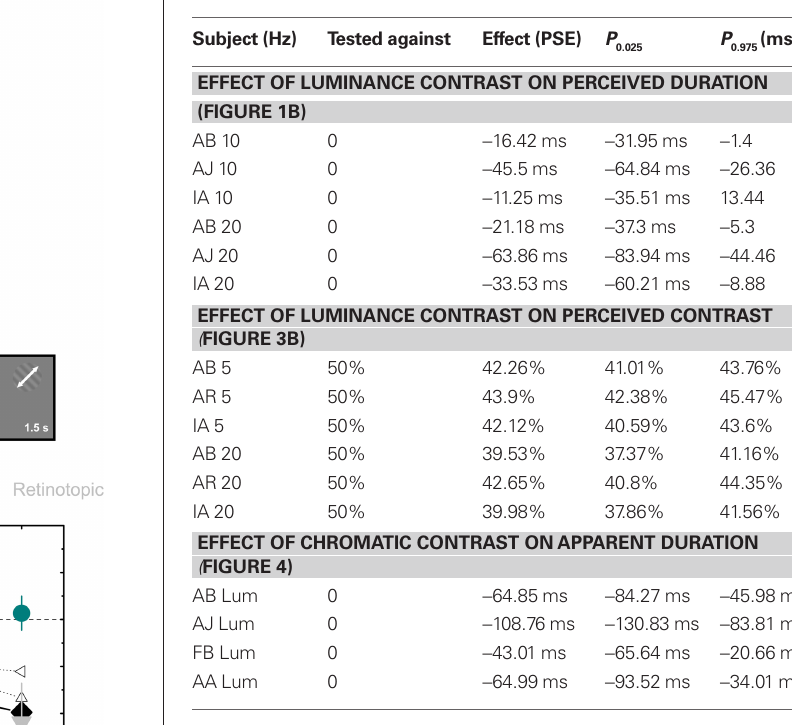
Table 1 | Statistical analysis of individual psychometric